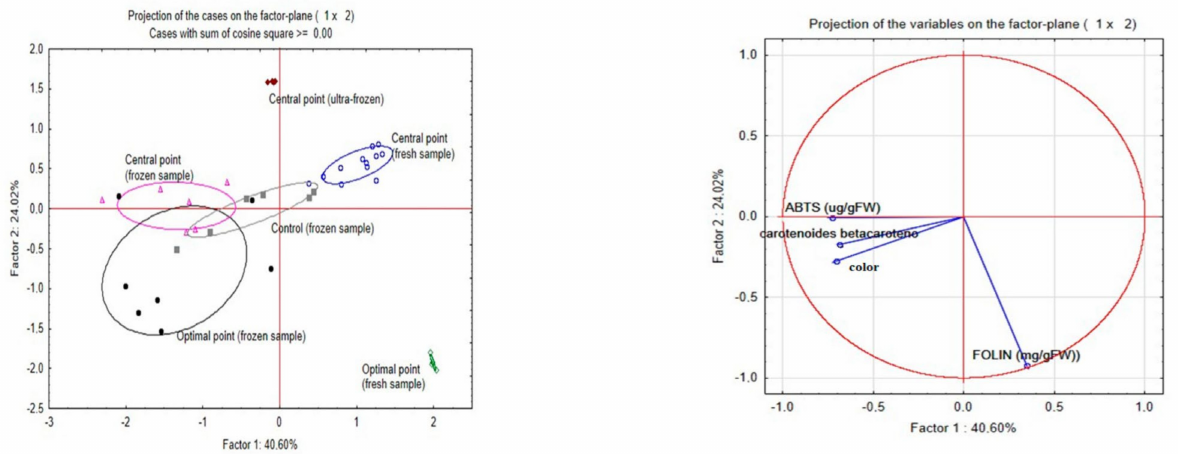
Figure 4. PCA analysis to principal variables, ABTS, Folin, carotenoids and colour of fresh and frozen